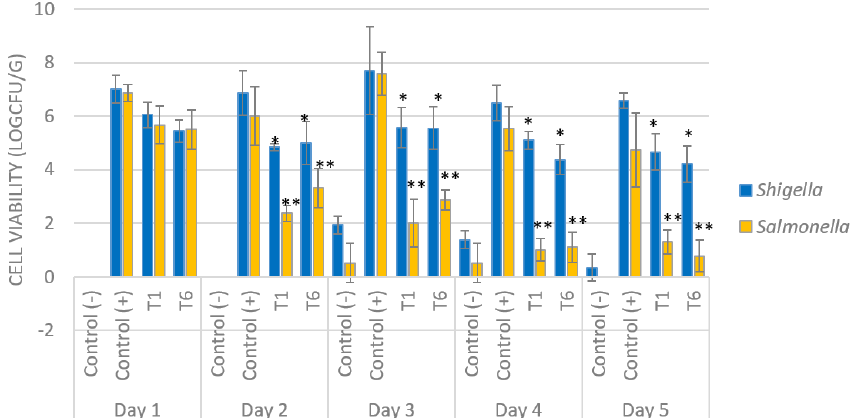
Figure 5. Enumeration of Salmonella and Shigella in the pineapple slices treated and untreated with peptide-based formulations during storage with refrigeration. Legend: Control (−): fruit slices, no pathogens, no peptide; Control (+): fruit slices + indicator cocktail; T1: fruit slices treated with indicator cocktail + formulation T1 (CFS); T6: fruit slices treated with indicator cocktail + formulation T6 (PP); T1: Cys5-4CFS + Gt28CFS:1:1 v/v; T6: Cys5-4PP + Gt28PP::1 v/v. *,**, significant decrease (P < 0.05) in cell counts vs. control (+).